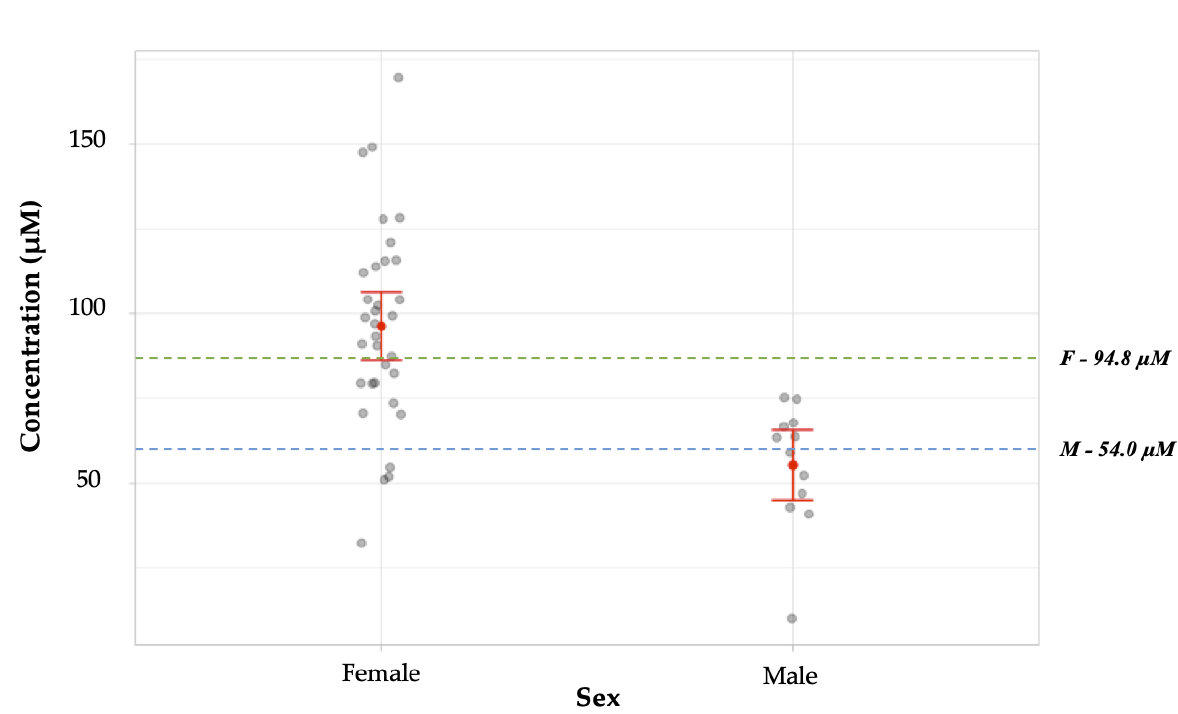
Figure 10. Comparison of mean arginine concentrations obtained from male vs. female individual samples in a blind study. These means were found to have a significant statistical difference ( p < 0.001). For males ( n = 12), the mean obtained was 55.26 ± 5.3 µM (SEM), which was not statistically different from the literature value, 54.0 ± 12.6 µM ( p = 0.914) [15]. The mean concentration obtained experimentally for samples from female donors ( n = 33), 96.4 ± 5.1 µM, was not statistically different from the literature value, 94.8 µM ± 12.9 ( p = 0.908) [15]. The literature values are represented on the graph by green and blue broken lines for females and males, respectively. The gray dots represent values obtained for individual samples. The red dot represents the mean concentration obtained for each data set. The red horizontal lines represent the upper and lower bounds for the 95% confidence intervals.